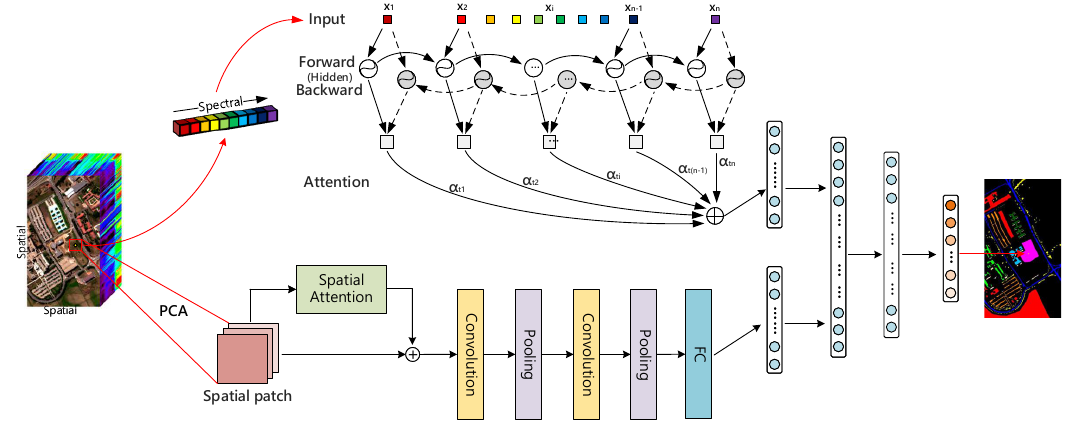
Figure 6. The whole structure of our proposed model. The spectral attention Bi-RNN branch and the spatial attention CNN branch are followed by a multi-layer merge network to extract conjoint spatial-spectral